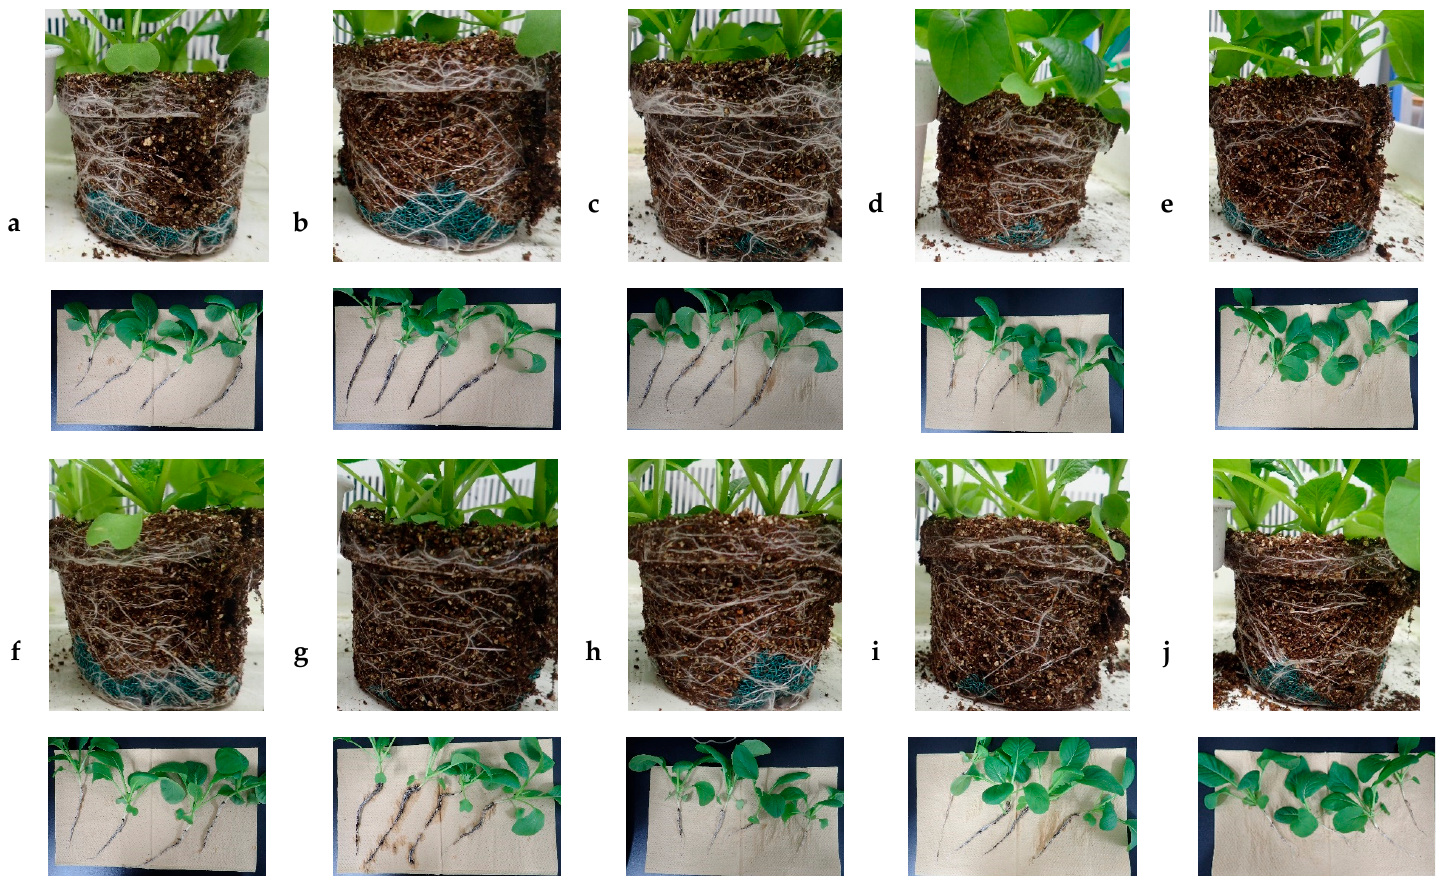
Figure 6. E ff ect of PDJ on root growth and development of komatsuna. Pictures were taken on the final day (day 21) of pot culture of seedlings treated with 0 ( a , f ), 200 ( b , g ), 400 ( c , h ), 600 ( d , i ), and 1000 ( e , j ) ppm PDJ applied drip-wise ( a – e ) or by spraying ( f – j ). PDJ at concentrations of 200 and 400 ppm ( b , g and c , h ) resulted in more complex, thicker, and stronger root networks, and at concentrations of 600 and 1000 ppm ( d , i and e , j ) resulted in less complex, thinner, and weaker root networks. In general, lower concentrations (200–400 ppm) of PDJ applied drip-wise, rather than by spraying, stimulated root growth and development. PDJ applied drip-wise led to stronger and more robust roots, and better incorporation between soil and roots; PDJ applied by spraying led to weaker and more fragile roots, and a crumbly and brittle (loose) soil